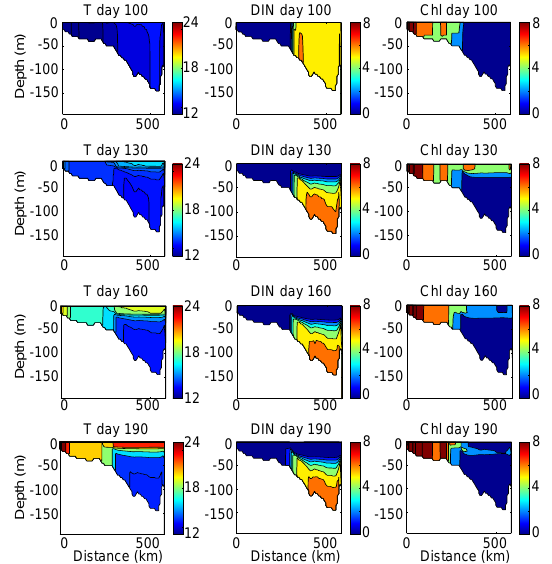
Figure 10. Sections through the developing tidal mixing front of the East China Sea, along 32 ◦ N, on days 100, 130, 160 and 190 of 2013: temperature (left column); DIN (mmolm − 3 , middle column); chl a (mgchl a m − 3 , right column).